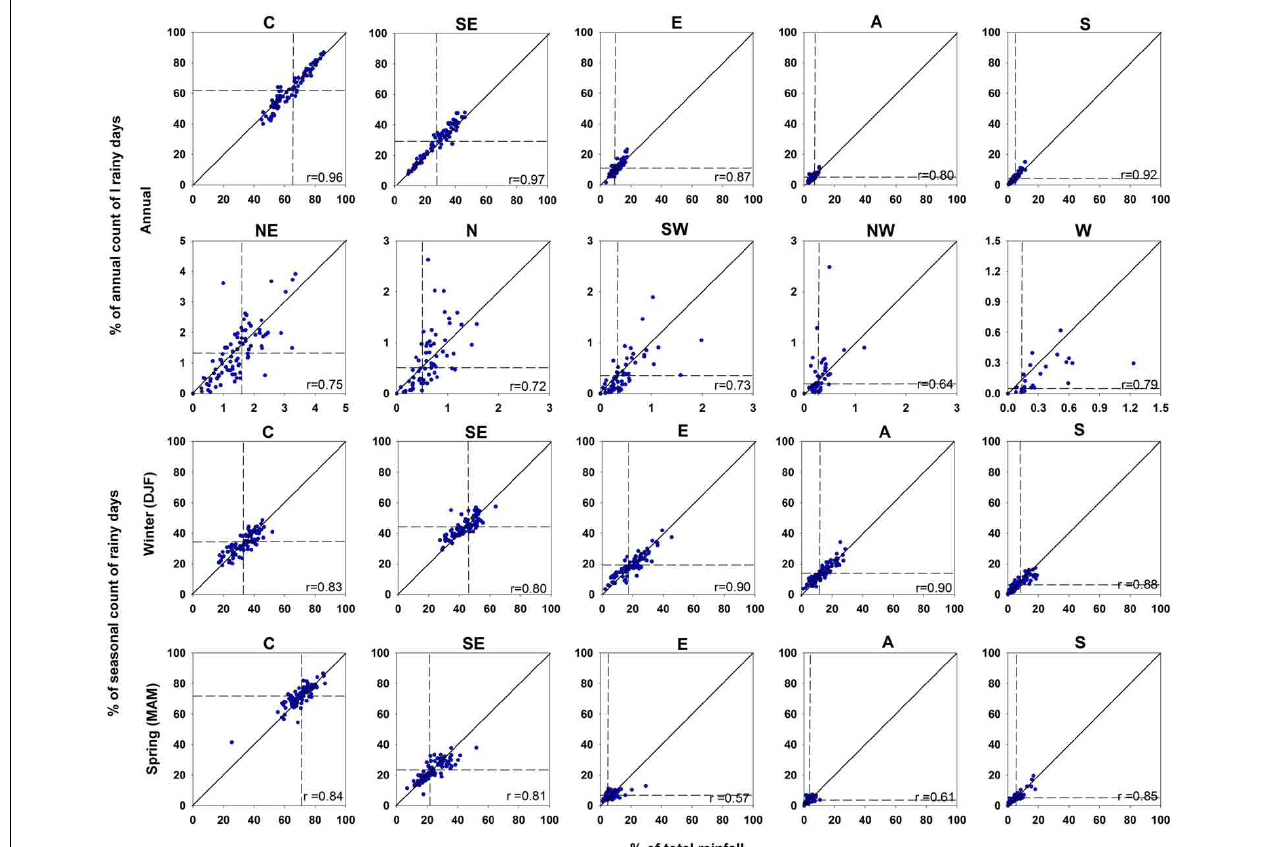
FIGURE 8 | Scatter plots between the ratio of total rainfall corresponding to each weather type and the total rainfall of all rain-days ( > 1mm) for each observatory (X-axis) against the ratio of the count of rain-days corresponding to each weather type and the count of all